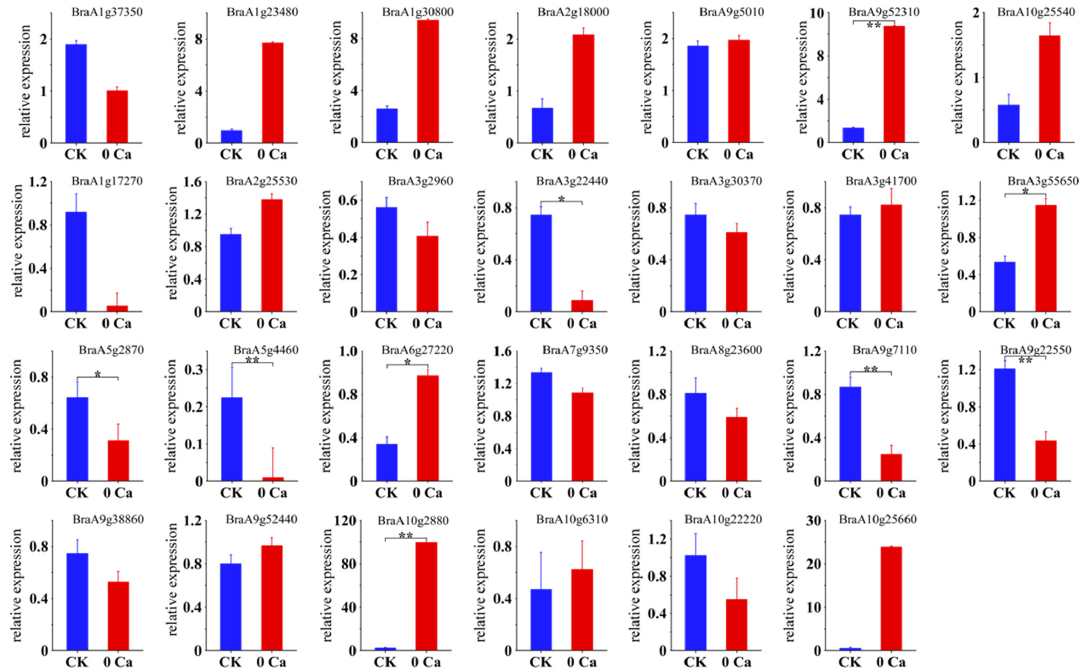
Figure 6. RT - qPCR verification of the DEGs. Asterisks indicate statistical significance using Student’s t -test: *, p ≤ 0.05, **, p ≤